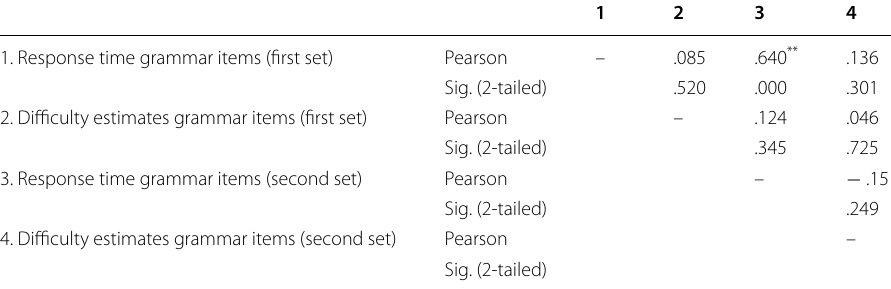
Table 3 Pearson’s product moment correlation of response time and difficulty estimates (grammar items)